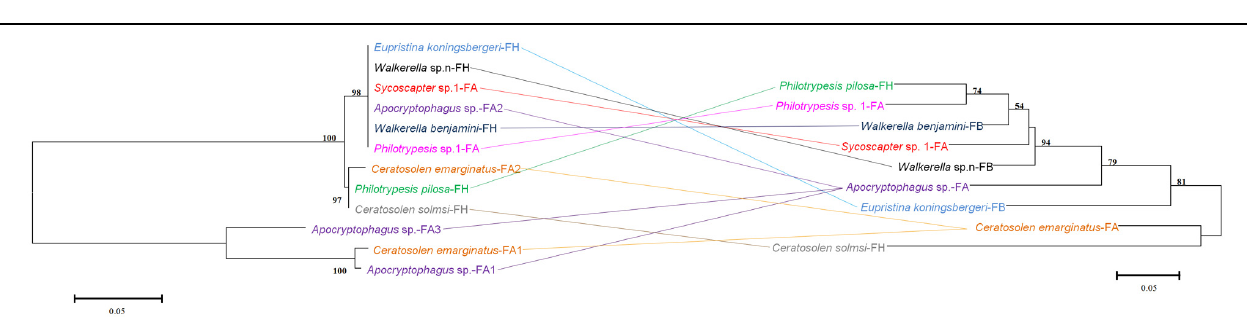
FIGURE 4 | Comparison between phylogenies of bacteriophage WO based on the orf7 sequence (left) and fig wasps based on the COI sequence (right). Samples tested in our survey are named by insect host name followed by the fig name (FA: Ficus auriculata, FH: Ficus hispida , FB: Ficus benjamina ), and haplotype